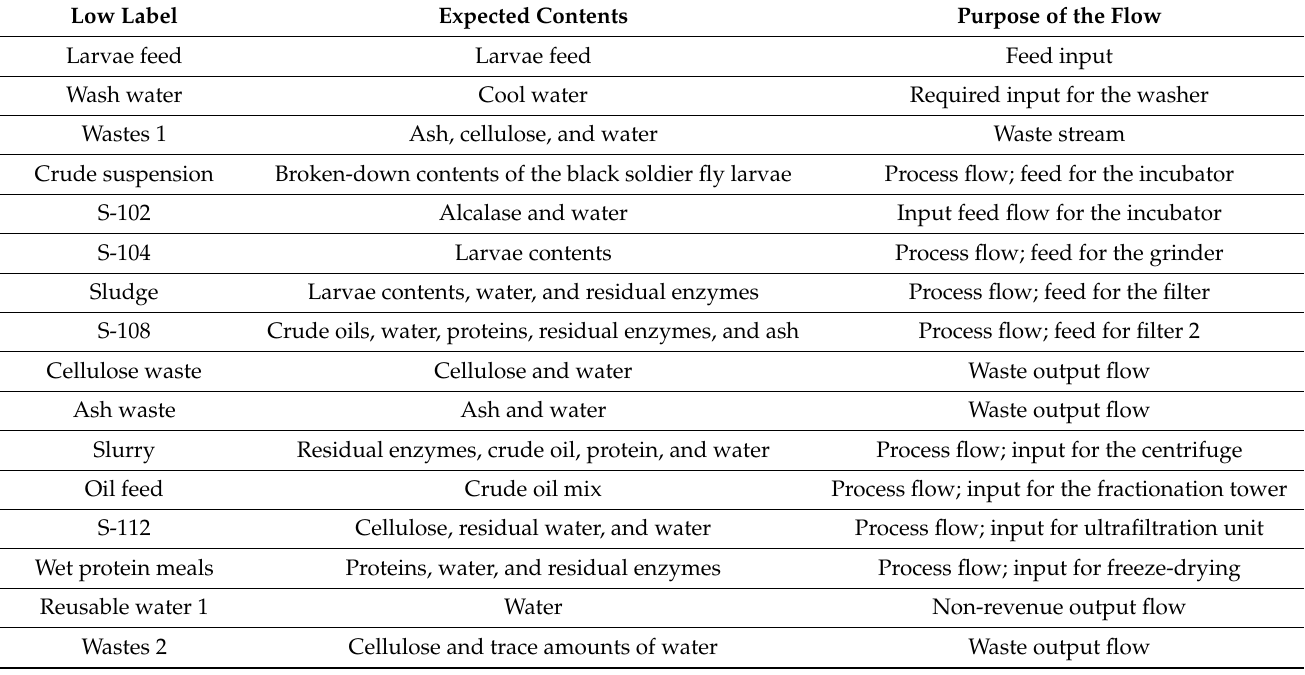
Table 5. The contents of active flows within the